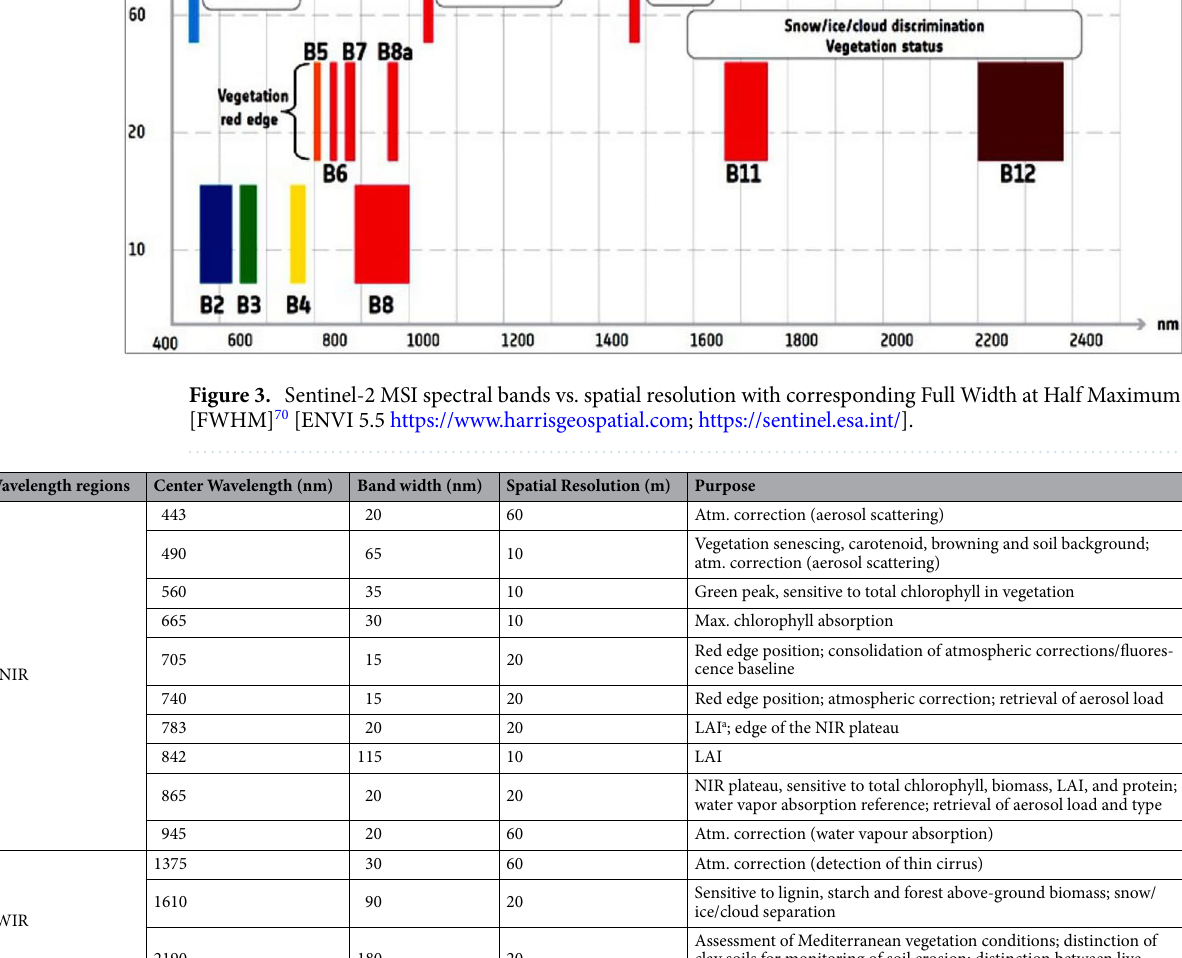
Construction of band ratios and indices enhance spectral differences between bands and reduce the effects of topography. Several indices have been constructed and available at the Index database (IDB) specifically for Sentinel-2 satellite (https ://custo m-scrip ts.senti nel-hub.com/custo m-scrip ts/senti nel-2/index db/). In this study,